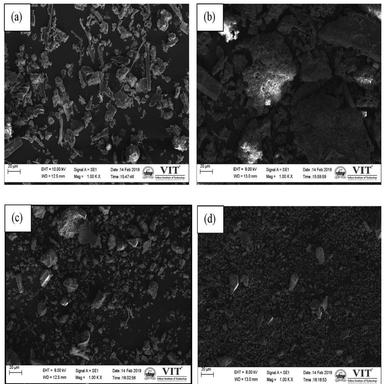
SEM images (a) SCBA, (b) SCBA 1, (c) SCBA 2 & (d) MK.